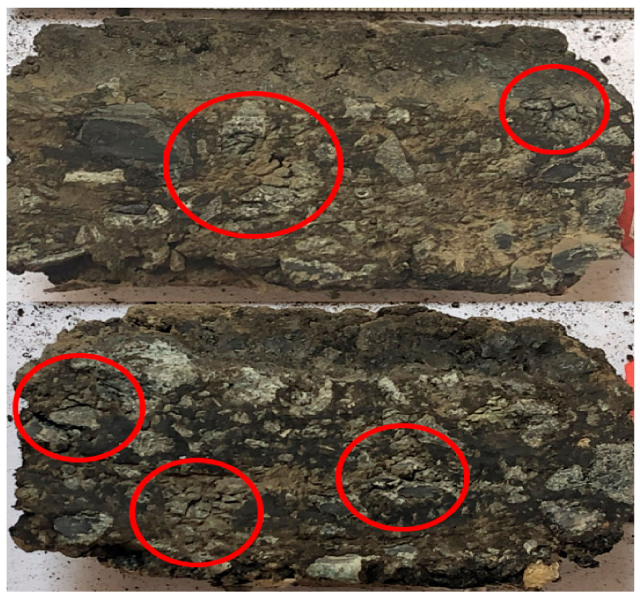
Figure 5. Broken part in the cross-section view of the